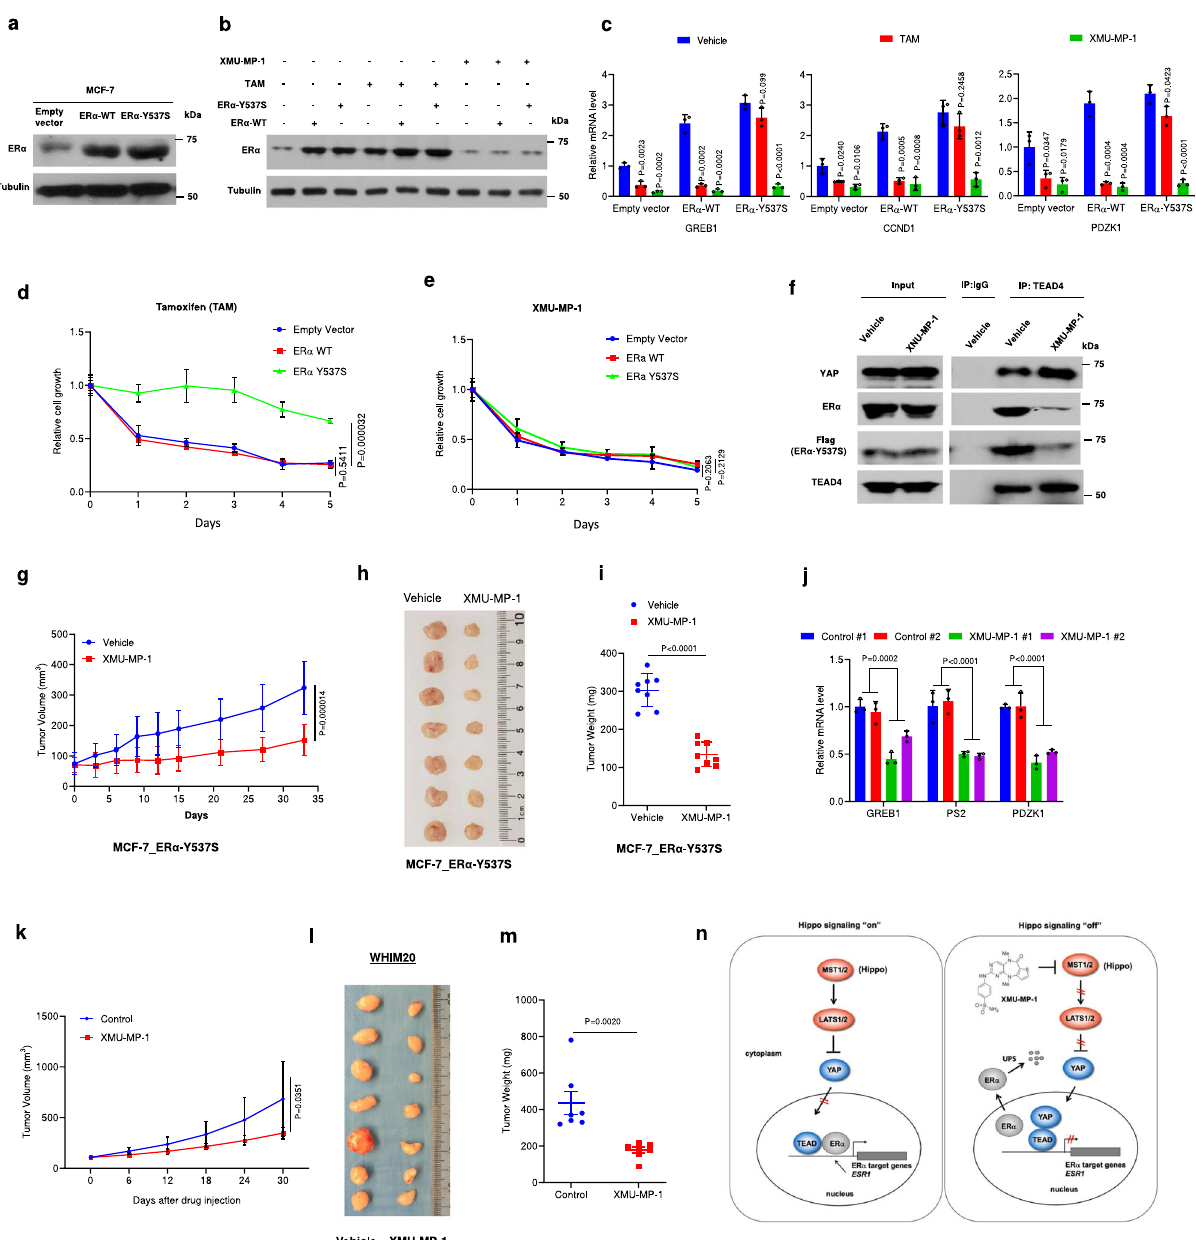
Fig. 7 MST1/2 inhibition overcomes hormone therapy resistance. a Western blot analysis to show the expression ER α in control and MCF-7 cells transfected with lentivirus carrying wild-type (WT) or mutant (Y537S) ER α . b XMU-MP-1 downregulated both ER α -WT and ER α -Y537S. MCF-7 cells expressing ER α -WT or ER α -Y537S were treated with 3 μ M XMU-MP-1 or 1 μ M tamoxifen for 24 h, followed by western blot analysis. c XMU-MP-1 but not tamoxifen (TAM) suppressed ER α -Y537S activity. Control and MCF-7 cells expressing ER α -WT or ER α -Y537S were treated with 3 μ M XMU-MP-1 or 1 μ M tamoxifen for 24 h, followed by RT-qPCR analysis of ER α target gene expression. d , e XMU-MP-1 but not tamoxifen inhibited the growth of ER α -Y537S- expressing cells. MCF-7 cells expressing ER α -WT or ER α -Y537S were seeded into 96-well plates and treated with tamoxifen ( d ) or XMU-MP-1 ( e ) at the indicated concentrations, followed by the WST-1 assay. f XMU-MP-1 inhibited TEAD4/ER α -Y537S interaction. MCF-7 cells expressing ER α -Y537S were treated with 3 μ M XMU-MP-1 for 2 h, followed by Co-IP and western blot analysis with the indicated antibodies. g – j XMU-MP-1 inhibited ER α -Y537S- expressing breast cancer tumor growth in xenograft. Female NSG mice carrying ER α -Y537S-expressing MCF-7 tumors were treated daily with vehicle or 3 mg/kg XMU-MP-1 for the indicated time. Tumor growth curve ( g ), photograph of tumor samples ( h ), quanti fi cation of tumor weight ( i ) and analysis of ER α target gene expression ( j ) at the end of treatment were shown. n = 7 for g , h . k – m , XMU-MP-1 inhibited hormone therapy-resistant breast cancer tumor in patient-derived xenograft model. Female NSG mice carrying WHIM20 tumors were treated daily with vehicle or 3 mg/kg XMU-MP-1 for the indicated time. Tumor growth curve ( k ), photograph of tumor samples ( l ), and quanti fi cation of tumor weight ( m ) at the end of treatment were shown. Each group n = 7. n YAP and TEAD have opposite effects on ER α transcriptional activity. See text for details. Results shown in b – f are representative of three independent experiments, results shown in g – m are from one set of experiments. Data are means ± s.d. Two-sided, unpaired t -test for c – e , g , i , j , k , m . Source data are provided in the Source Data fi